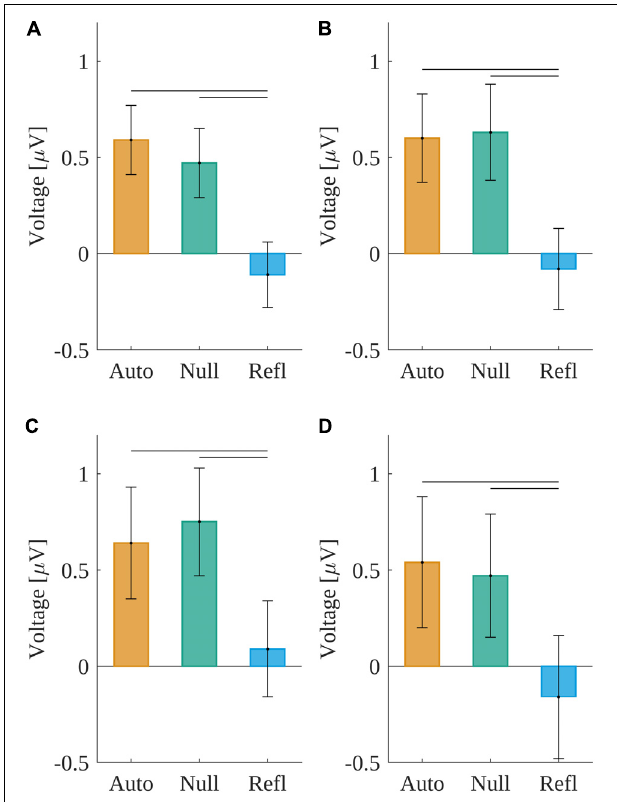
FIGURE 9 | Grand mean amplitudes across participants for origin levels within the time windows: (A) from –480 to –330 ms, (B) from –330 to –230 ms, (C) from –230 to –140 ms, and (D) from –140 to 0 ms. Horizontal lines indicate levels of origin that differ significantly from each